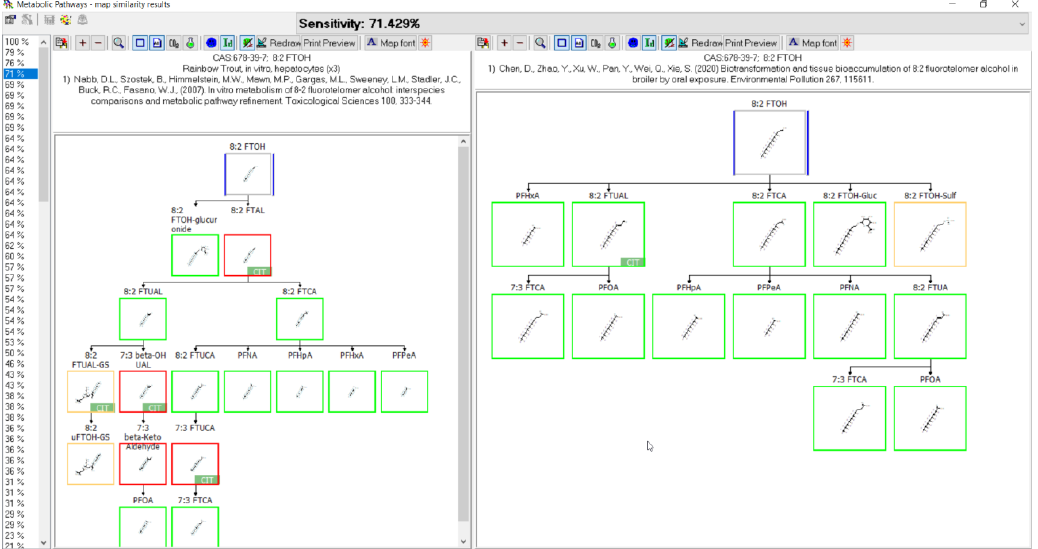
Figure 16. Metabolic map comparison of 8:2 FTOH in ( left ) rainbow trout hepatocytes and ( right ) in vivo chicken. Metabolites common to both species are indicated by green boxes. Differences in metabolites are indicated by red boxes. Tan boxes indicate phase II conjugates. Sensitivity, in this case 71.429%, is an assessment of the map comparison whereby the number of common metabolites is divided by the total number of metabolites in the fish map. Metabolites labeled with CIT are presumed intermediates in the path but were not identified in the study.